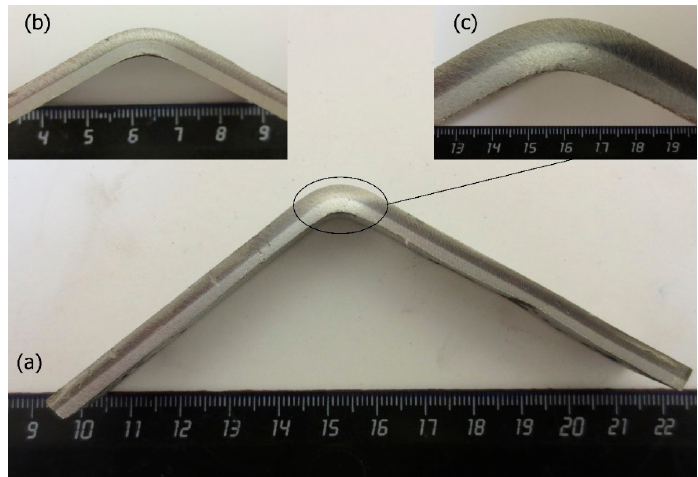
Figure 14. Macrograph of explosively welded bimetal plate after bending (120°): ( a ) general view; ( b ) AlMg6–titanium specimen; ( c ) AlMg6–08Cr18Ni10Ti specimen.